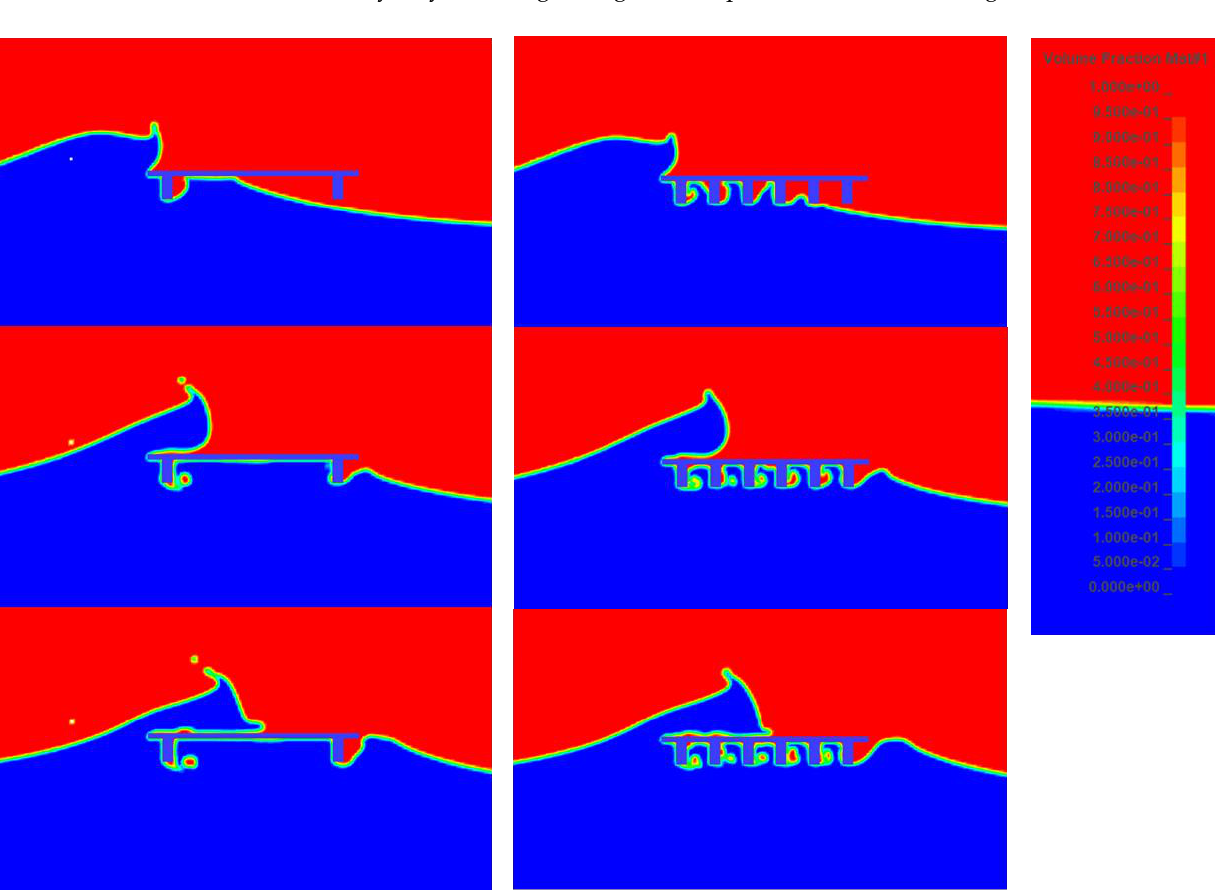
Figure 14. Snapshots of the vectors of the volume fraction for wave SW3.6 ( H = 0.85 m) impacting a deck with two girders ( left ) and six girders ( right ) at three instants: t = 6.4 s (top), t = 6.6 s (center) and t = 6.7 s (bottom).